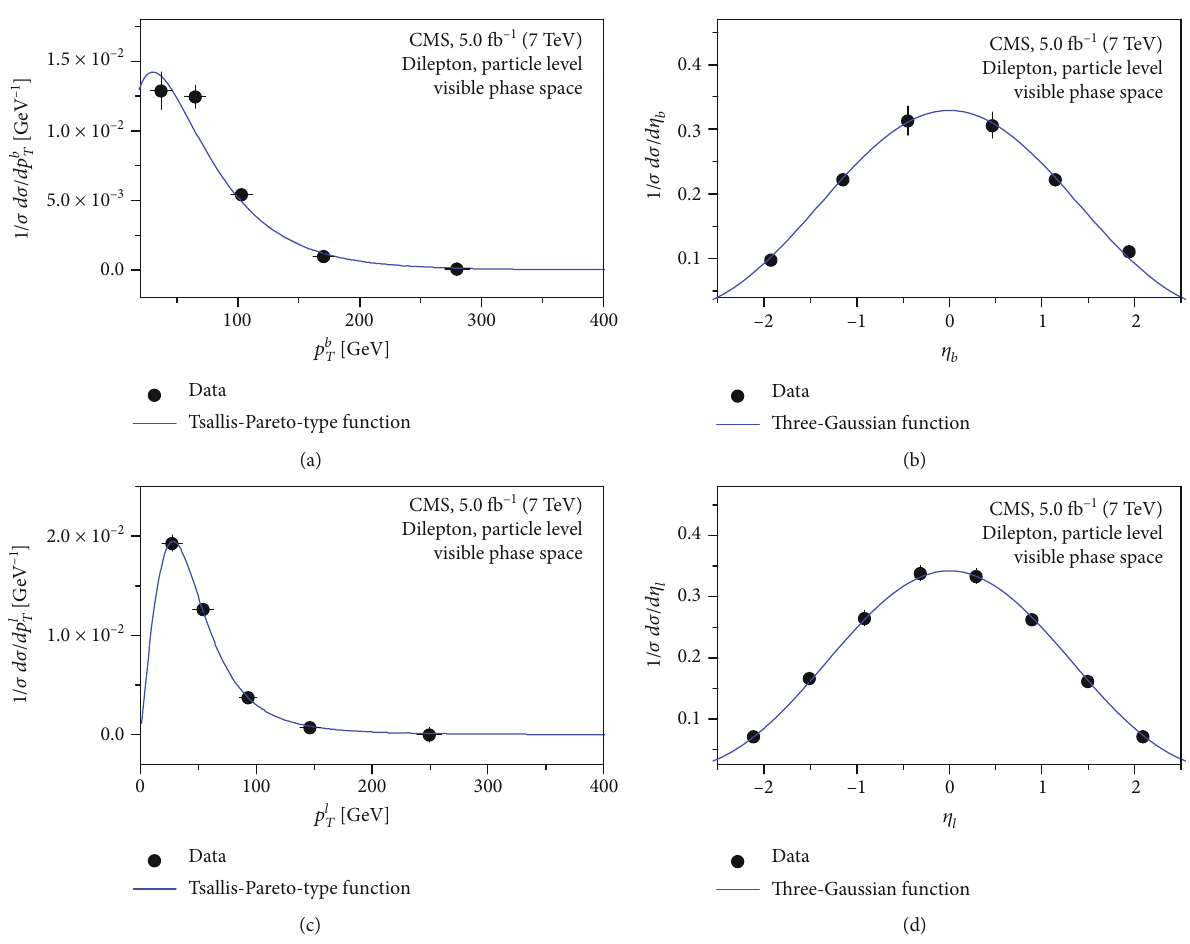
Figure 12: The same as Figures 1 and 5, but showing the results of b and l produced in pp collisions at the particle level in the visible phase ffiffi p s = 7 space at